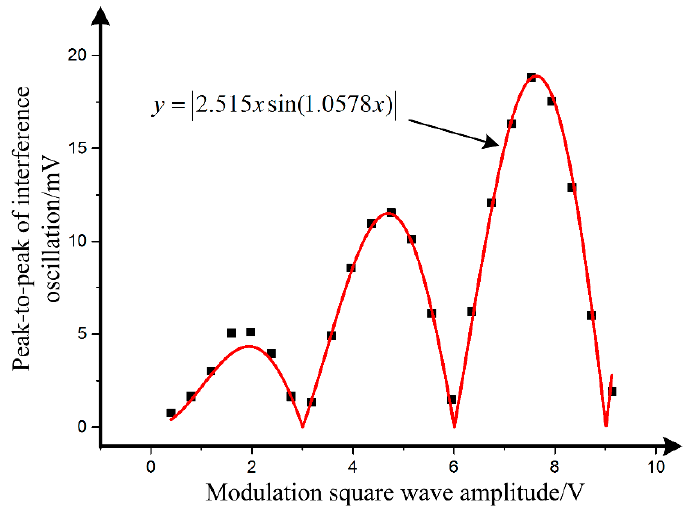
Figure 7. Measured peak-to-peak value of interference oscillation as a function of modulation square wave amplitude and its model fitting.